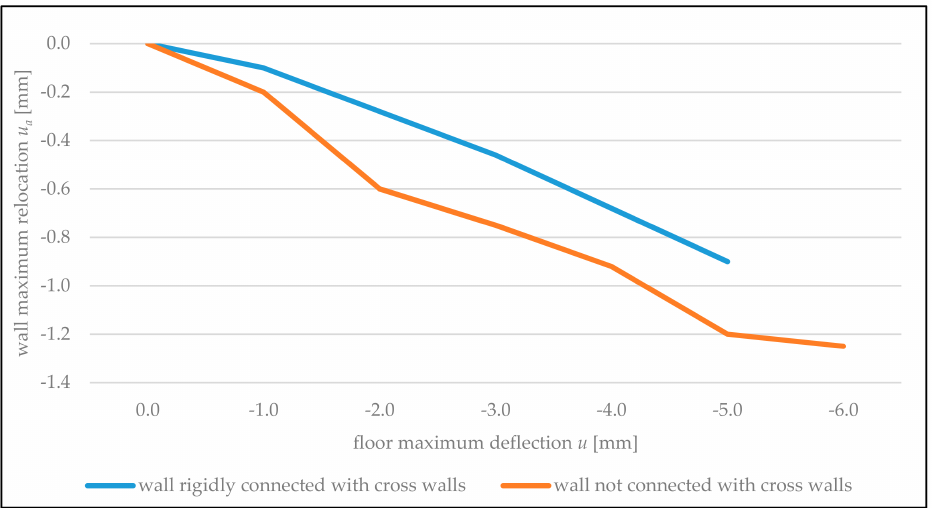
Figure 15. Graphs of maximum vertical relocations of the bottom edge of the wall ( u a ), depending on maximum deflection of the floor ( u